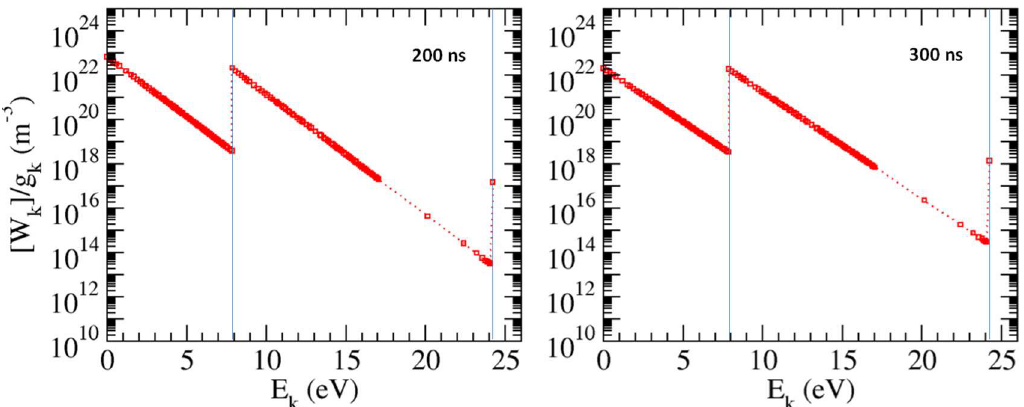
Figure 11. Boltzmann plots at 200 and 300 𝑛𝑠 for an argon gas at atmospheric pressure. The first ( 7.86 𝑒𝑉 ) and second ionization ( 24.23 𝑒𝑉 ) limits are indicated by a vertical blue line. Each state is represented by a square. We see the added states following a hydrogen-like assumption between 20 and 24 𝑒𝑉 .